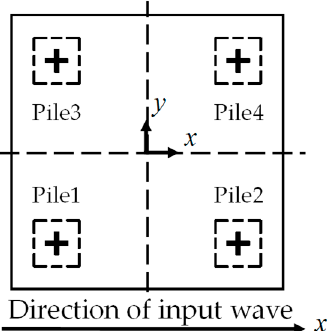
( b ) Figure 17. Influence of tangential stiffness on bending moment of Pile 1: ( a ) Change the value of tangential stiffness K s1 ; ( b ) Change the value of tangential stiffness K s2 . 3.5. Comparison of Different Piles Figure 18 shows arrangement of the four-pile group. Along the vibration direction ( x direction), Pile 1 and Pile 3 belong to the relationship of side-by-side piles, while Pile 1 and Pile 2 belong to the relationship of front and rear piles. In Figure 19, the bending moment envelopes of Pile 1 and Pile 3, Pile 1 and Pile 2 are very close, but a small differ- ence was observed, especially between Pile 1 and Pile 2. Furthermore, the time history curve of pile bending moment at 0.275 m close to the soil surface was selected and shown in Figure 20. The time history curves of bending moment of Pile 1 and Pile 3 are almost coincident, indicating that the motion state of the side-by-side piles in the pile group is the same. At the end of the vibration, Pile 1 and Pile 3 have almost the same residual bending moment of about − 38.8 kN ∙ m, indicating that residual deformation or stress of